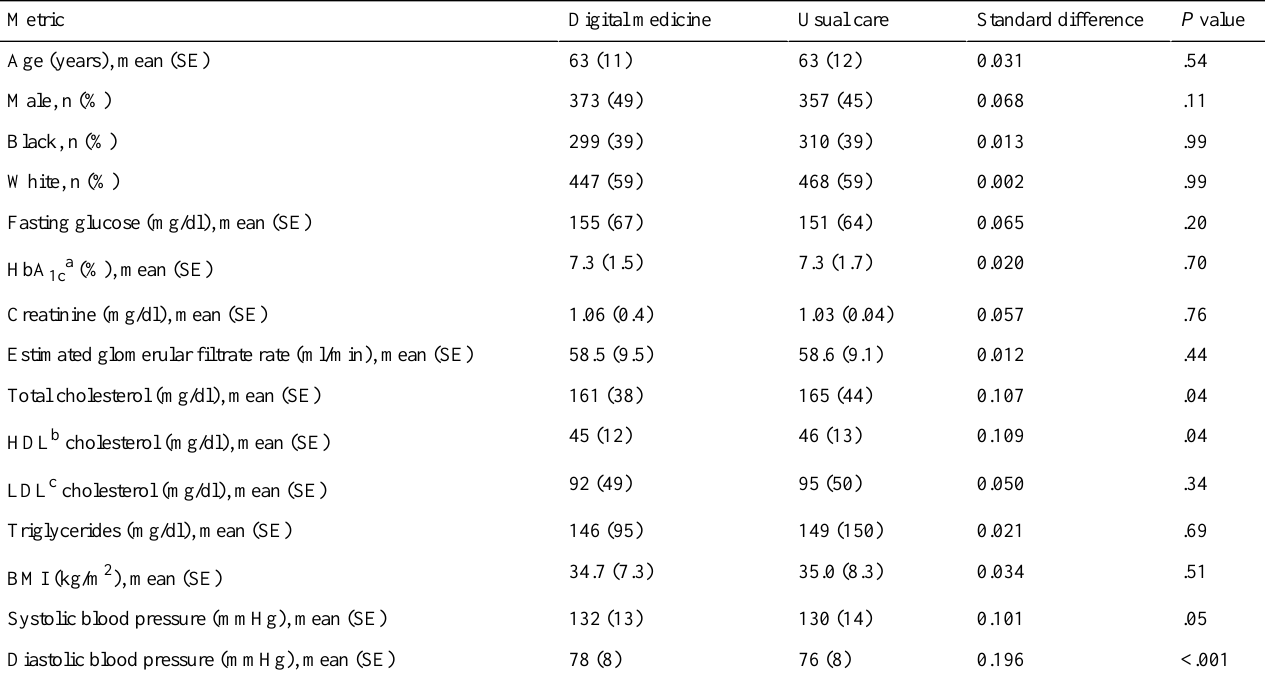
Table 1. Baseline comparison of digital medicine (n=763) and usual care (n=794).